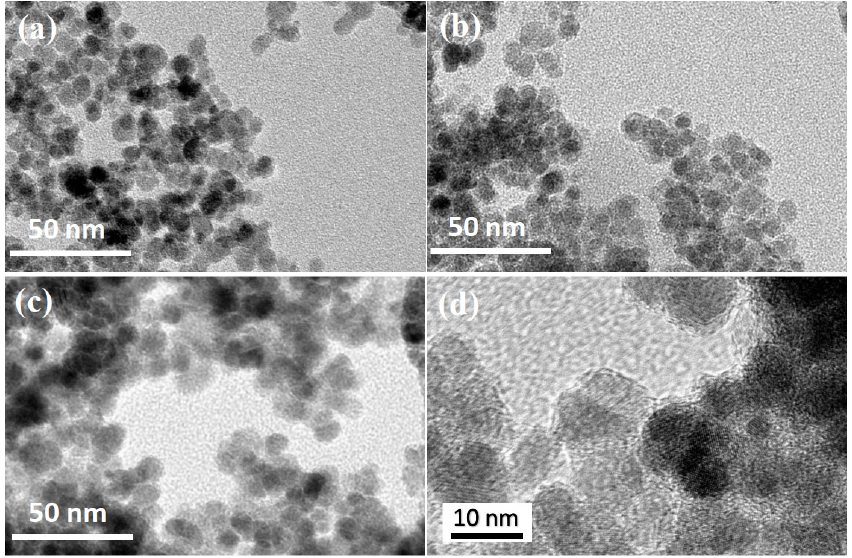
Figure 1. TEM morphologies of ( a ) Fe 3 O 4 ; ( b ) mag-hydrogel; ( c ) recoated-mag-hydrogel; and ( d ) recoated-mag-hydrogel in a larger